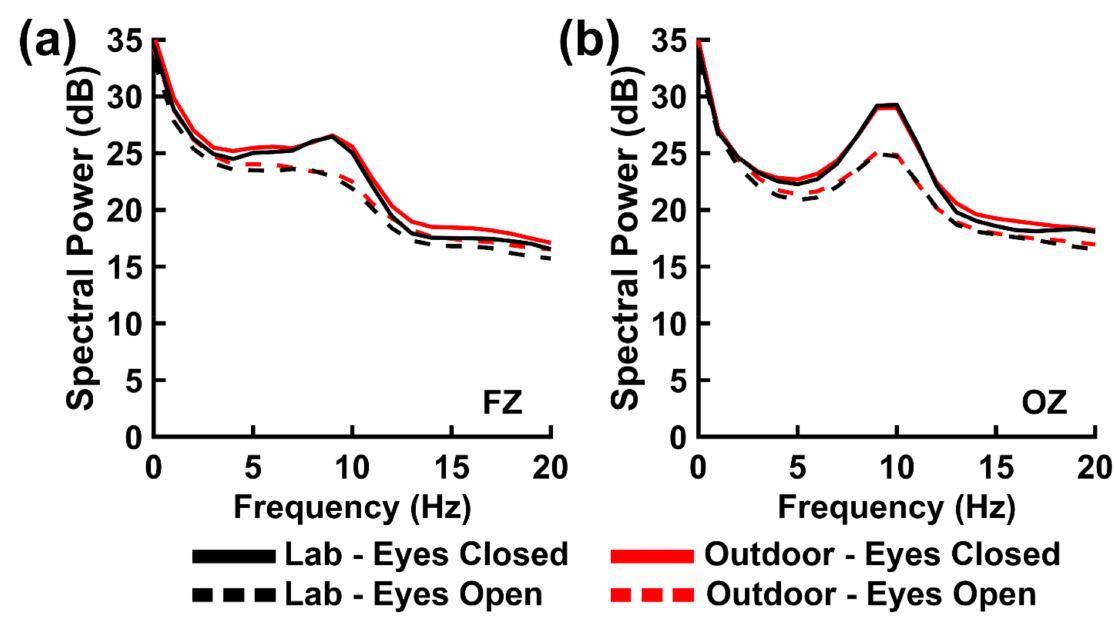
Figure 3. EEG spectral power (in decibels) at ( a ) frontal site FZ and ( b ) posterior site OZ for eyes closed (solid lines) and eyes open (dashed lines) resting states in the laboratory (black lines) and outdoor (red lines)